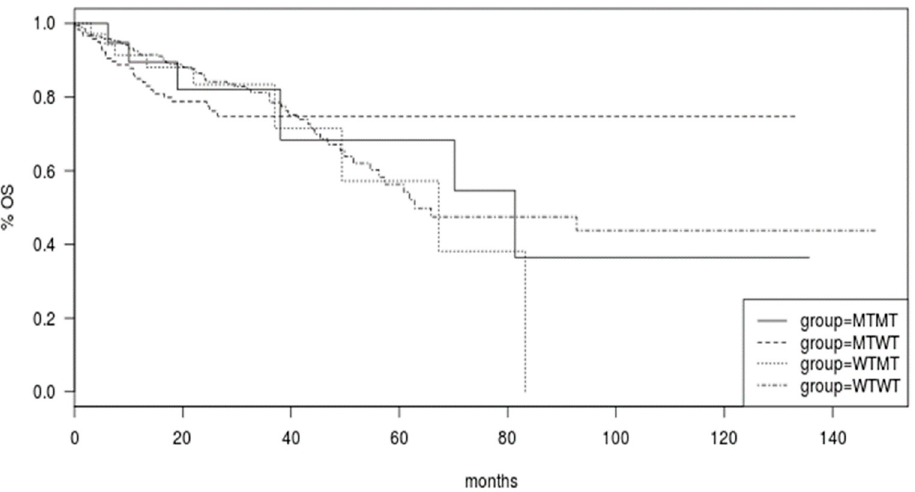
Figure 4. Overall Survival (OS) of patients in the colorectal cancer cohort of TCGA according to the mutational status of BRAF and PIK3CA genes. Group WTWT: both genes wild type; group WTMT: PIK3CA wild type/ BRAF mutant; group MTWT: PIK3CA mutant/ BRAF wild type; MTMT: both genes mutated.